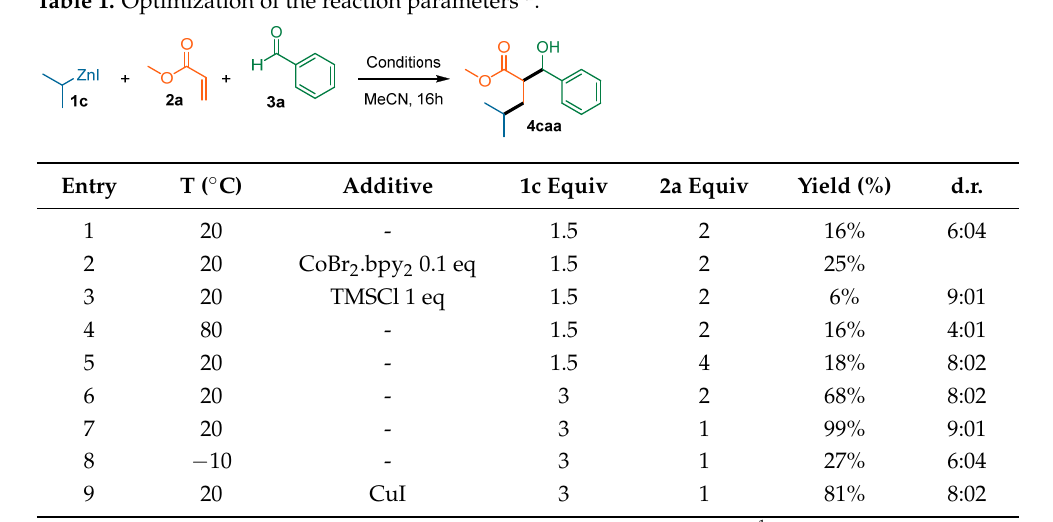
Table 1. Optimization of the reaction parameters a .